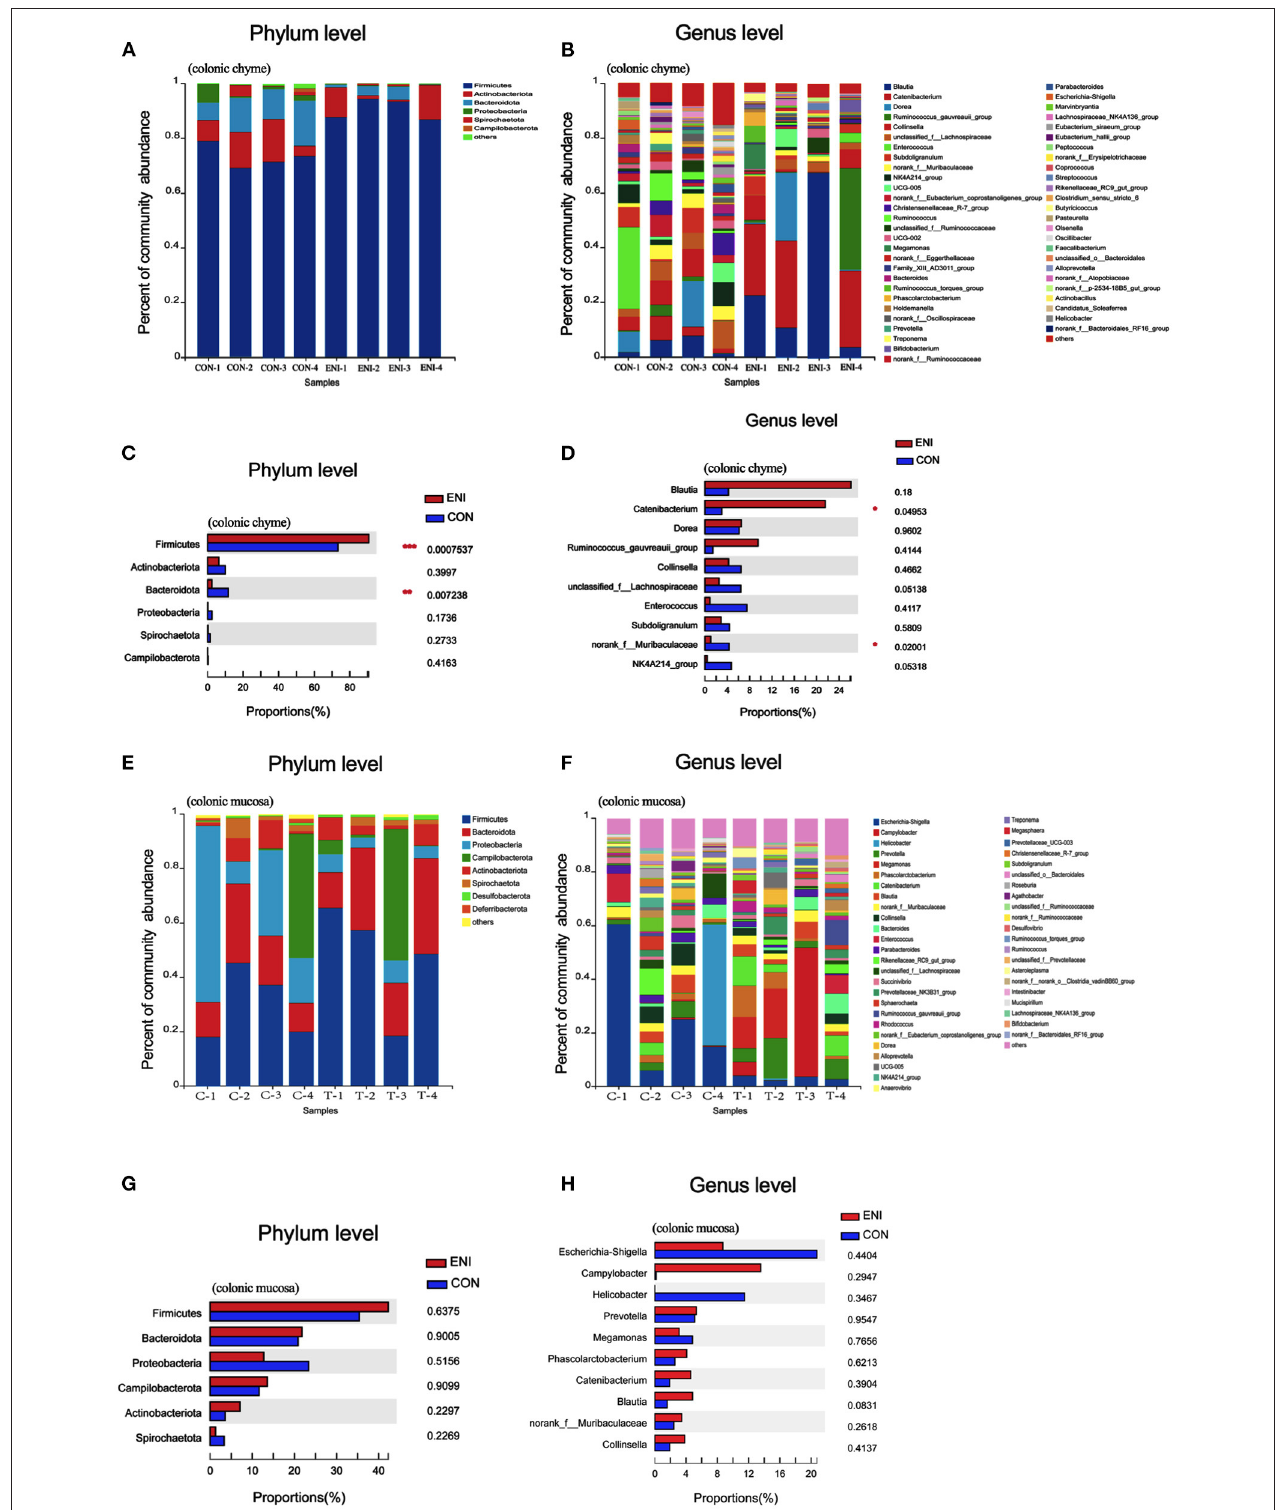
FIGURE 7 | Gut microbiota community composition in the colonic chyme and colonic mucosa of piglets. CON, control group, ENI, early-life nutrition interventions group. (A) The relative abundances of microbiota in colonic chyme at the phylum level. (B) The relative abundances of microbiota in colonic chyme at the genus